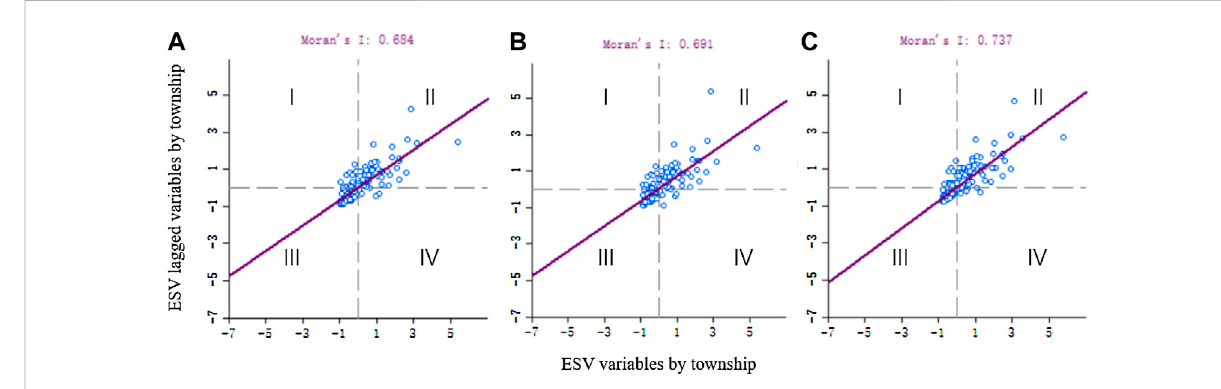
FIGURE 6 Moran ’ s I scatterplots of ESV in Luoyang City, in (A) 2010; (B) 2015; and (C)